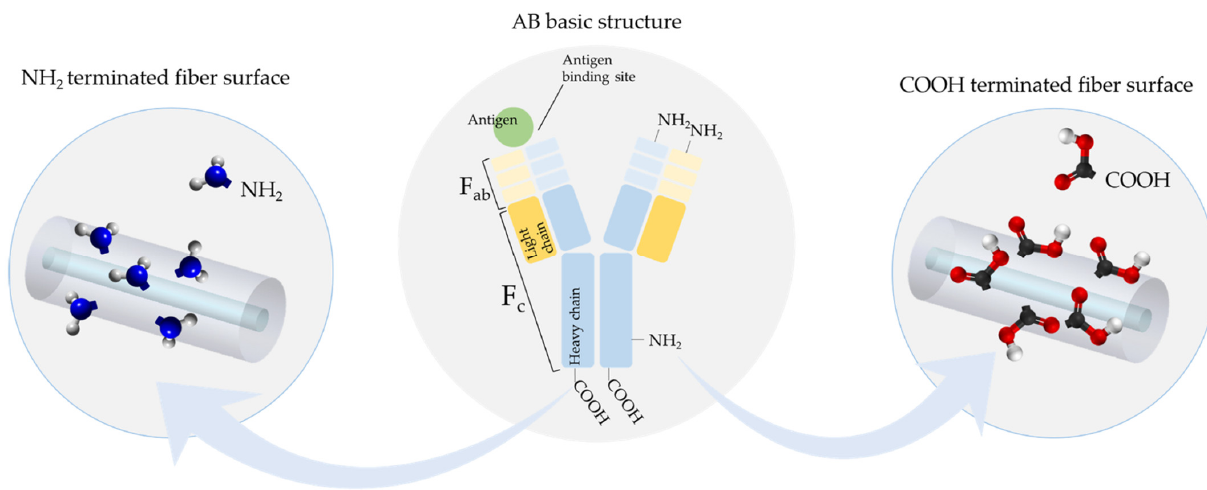
Figure 6. Schematic representation of the antibody structure ( center ) and the representation of amine ( left ) and carboxylic ( right ) functional groups onto the fiber surface used for antibody immobilization.